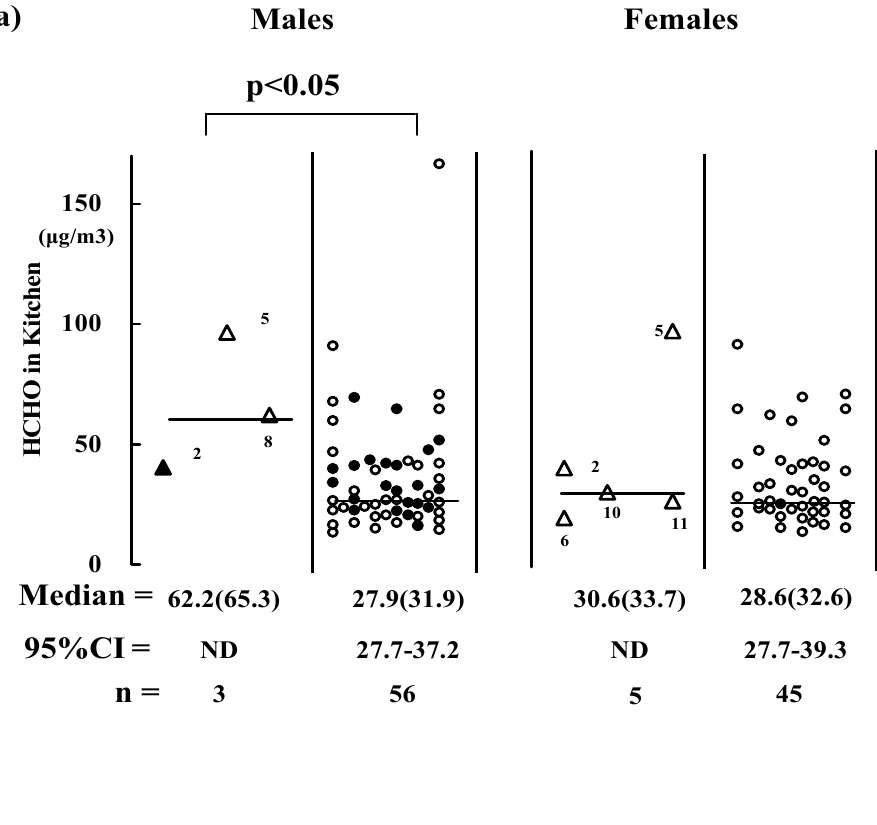
Figure 1. Air concentrations of HCHO, butanol, and 1, 2-dichloroethane in residences are shown in ( a ), ( b ), and ( c ), respectively. Residents with and without subjective symptoms after they moved into the flats are represented by (  , ▲ ) and ( triangles and circles are smokers). Bar = median value. Point estimation of median is in parenthesis; 95% CI = 95% confidence interval. ND = not determined because of the small number of